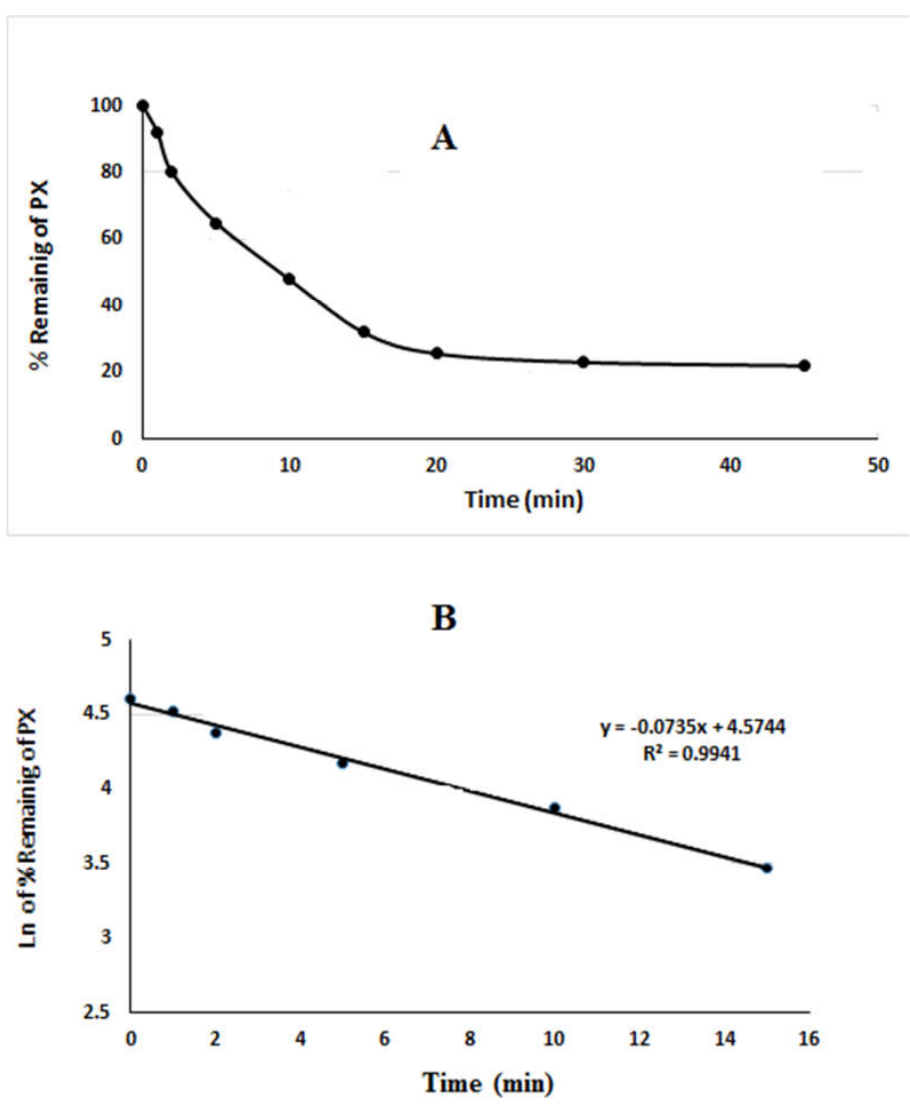
Table 5. The penalty points of the method for the determination and quantitation of the PX in plasma.